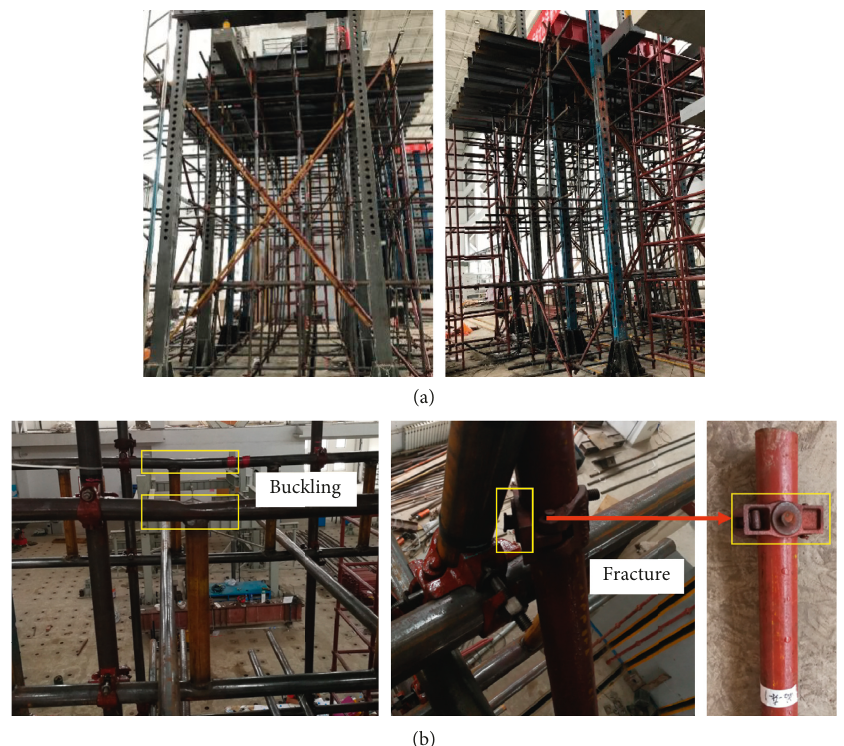
Figure 15: Failure situations of Model 2. (a) Overall buckling deformation of scaffold. (b) Bending of truss in the loading region. (c) Fastener failure at top of diagonal